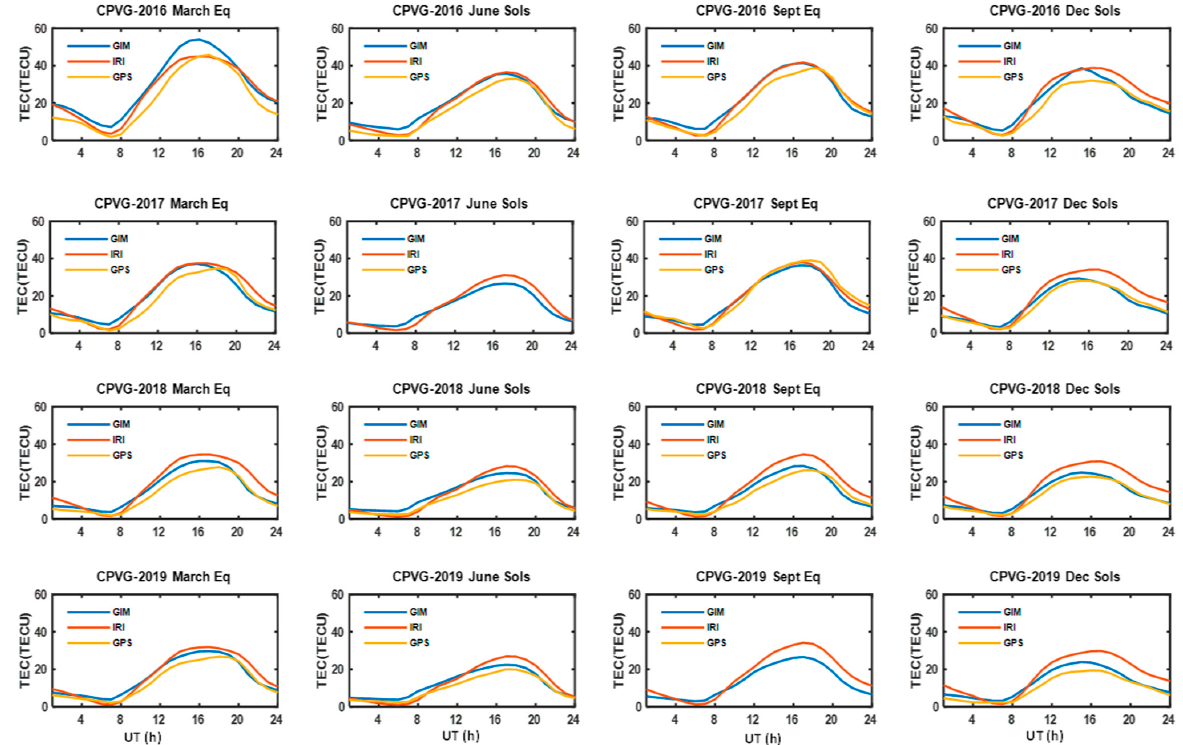
Figure 8. Seasonal variations in GPS-TEC, IRI-2016 and GIM models for descending (2016–2017) and minimum (2018–2019) phases of solar cycle 24 at CPVG.